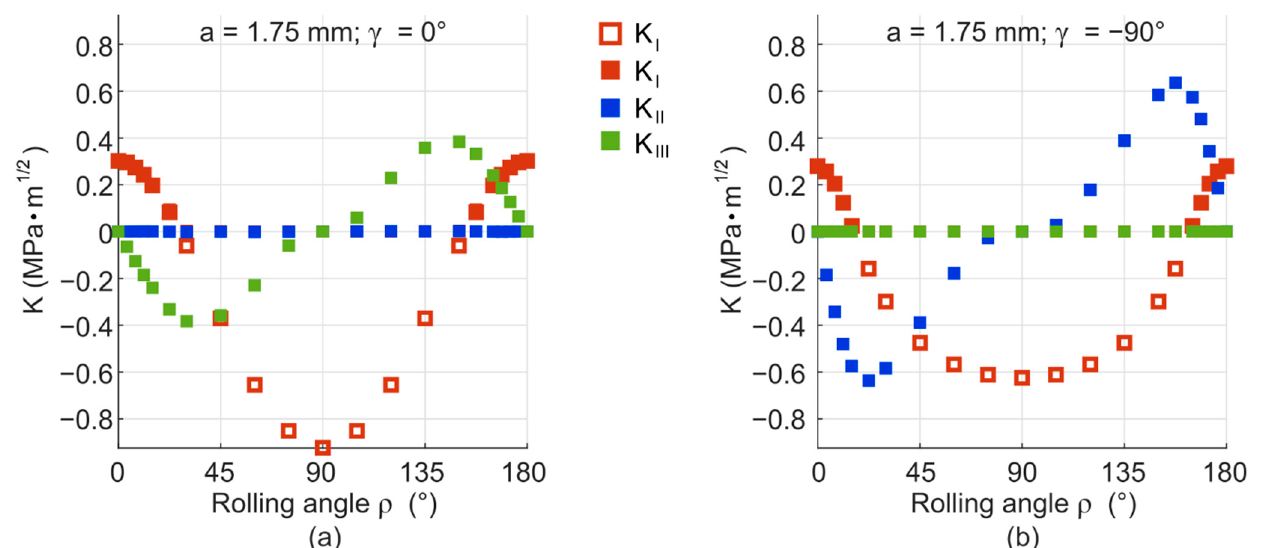
Figure A10. Course of stress intensity factors during rotation in the cylinder D × L = 6 × 6 mm 2 , load F = 350 N, a = 1.75 mm, position on the crack front; ( a ) γ = 0°; ( b ) γ = − 90°. Model including friction.